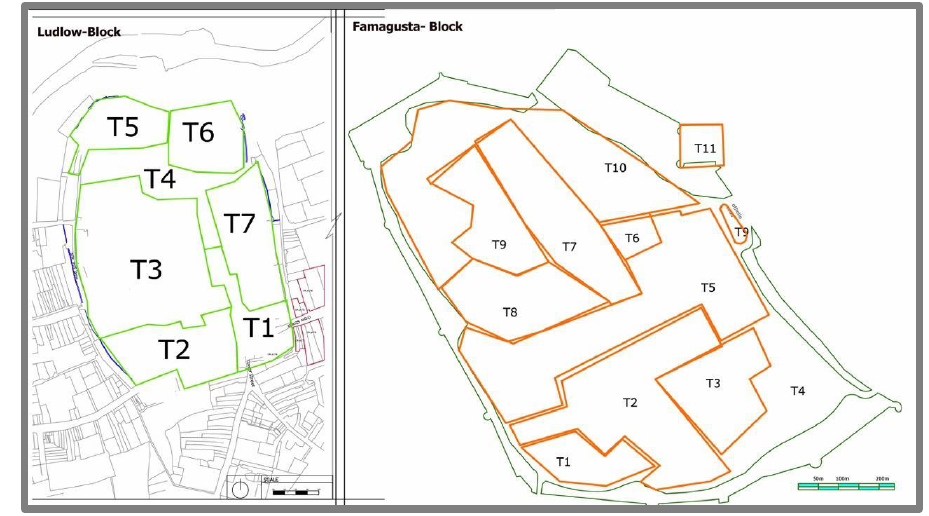
Figure 4 Ludlow and Famagusta Block Typology (Cömert, 2013)